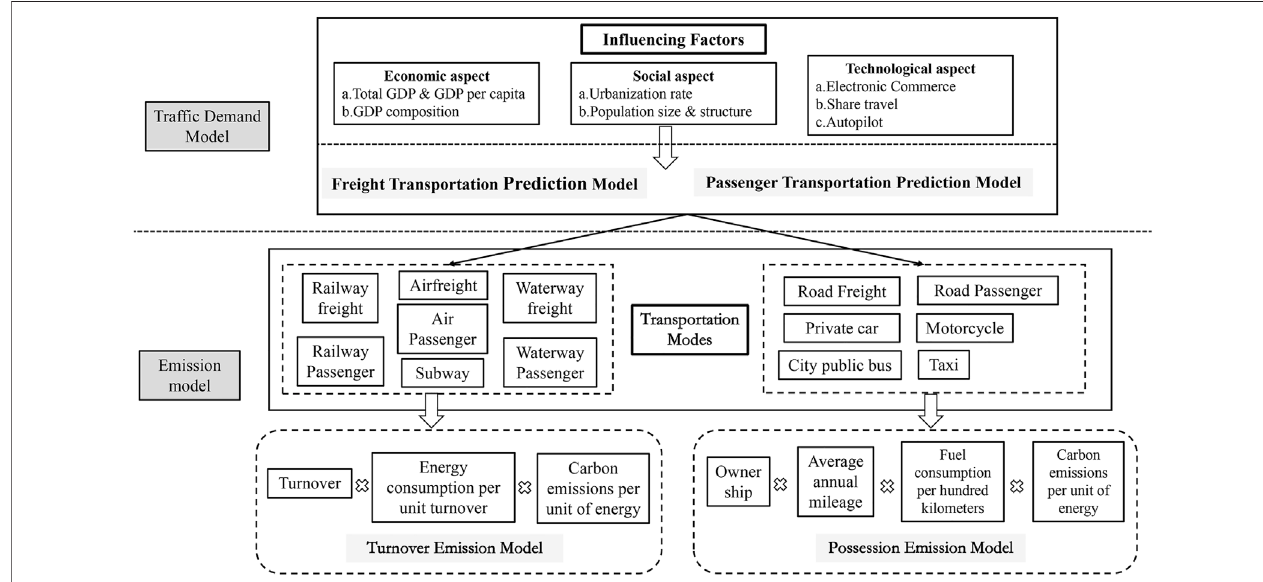
FIGURE 2 | Transport-related carbon emissions calculating